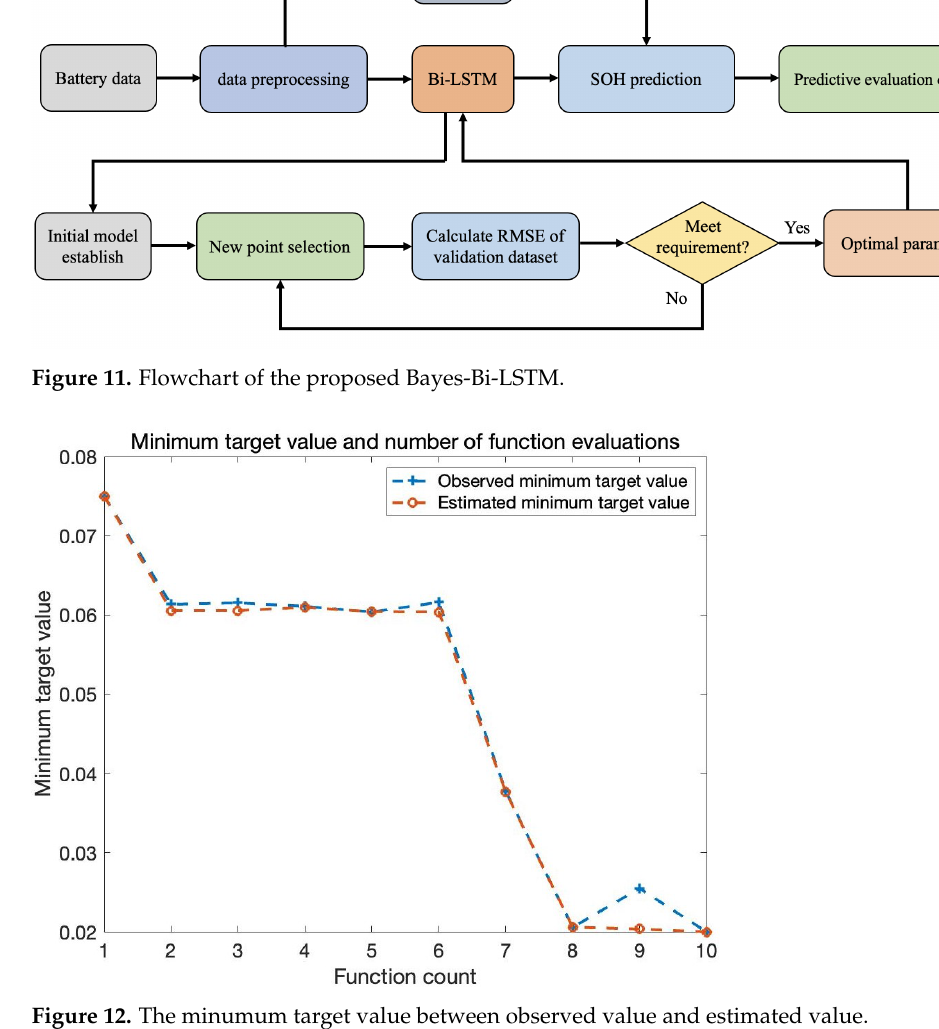
Figure 12. The minumum target value between observed value and estimated value.